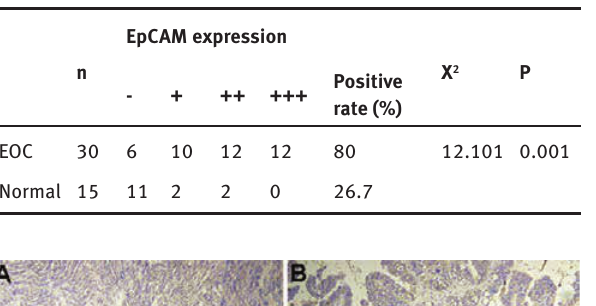
Table 2: Chi-square test analyses of EpCAM expression in EOCs and normal